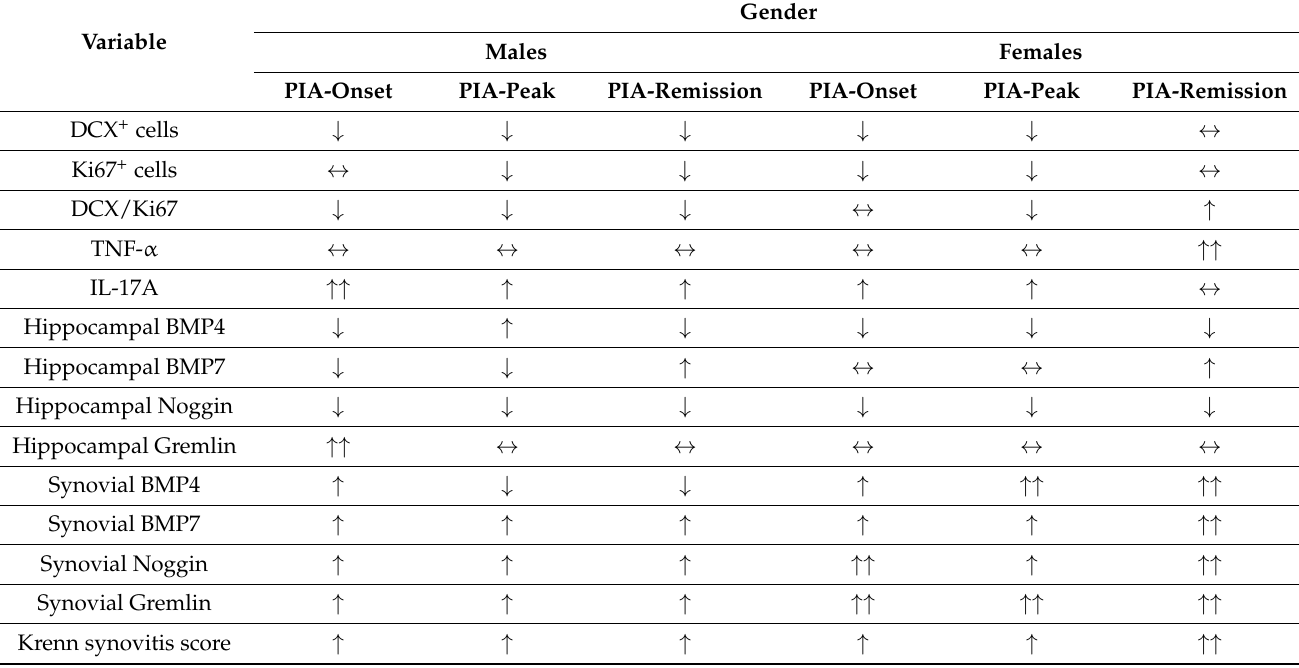
Table 3. Gender-related differences during